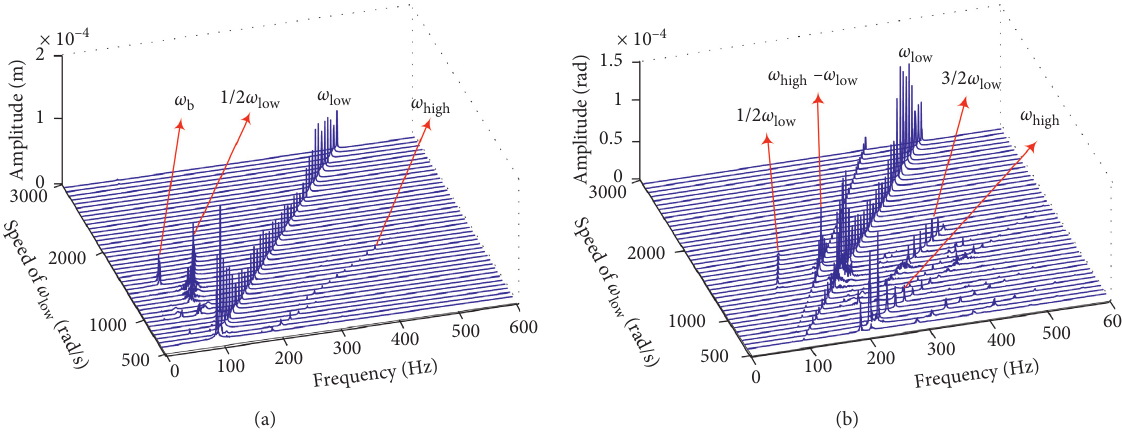
Figure 15: Spectrum cascades of the bending and torsional motions with varied rotating speeds ( ω (a) Bending motion and (b) torsional motion.